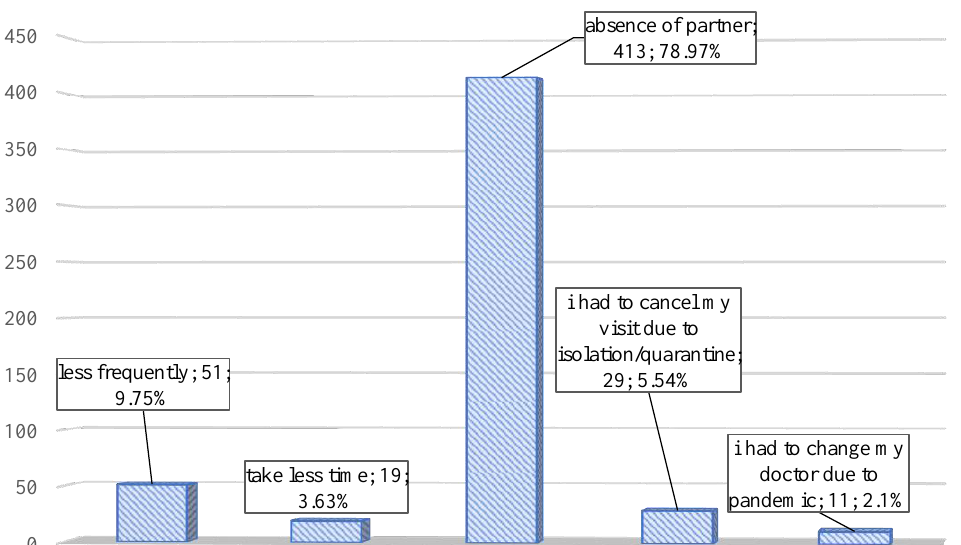
Figure 3. Factors that cause anxiety in pregnant women about the risk of COVID-19 infection. The impact of the pandemic on pregnancy check-ups was also analyzed. The hardest part for pregnant women was the absence of their partner during the visits. (Figure 4)